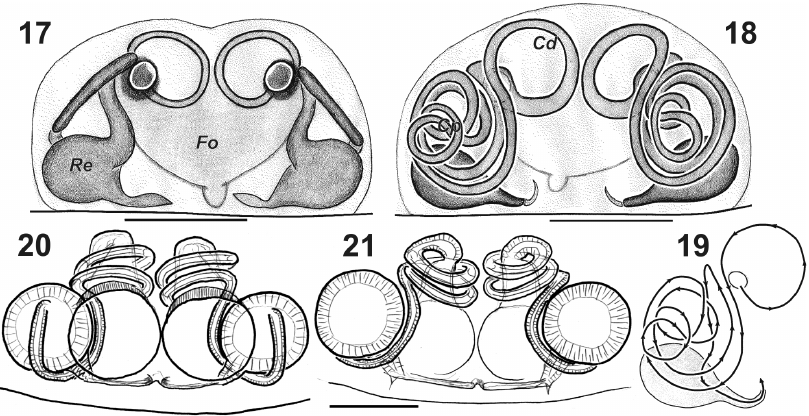
Figures 17–21. Epigynes of Lathys ankaraensis sp. n. ( 17–19 ) and L . stigmatisata (from Crimea 20–21 ). 17, 20 ventral 18, 21 dorsal 19 schematic drawing of insemination duct. Abbreviations: Cd copulatory ducts; Cp other coils; Fo fovea; Re Reseptacle.